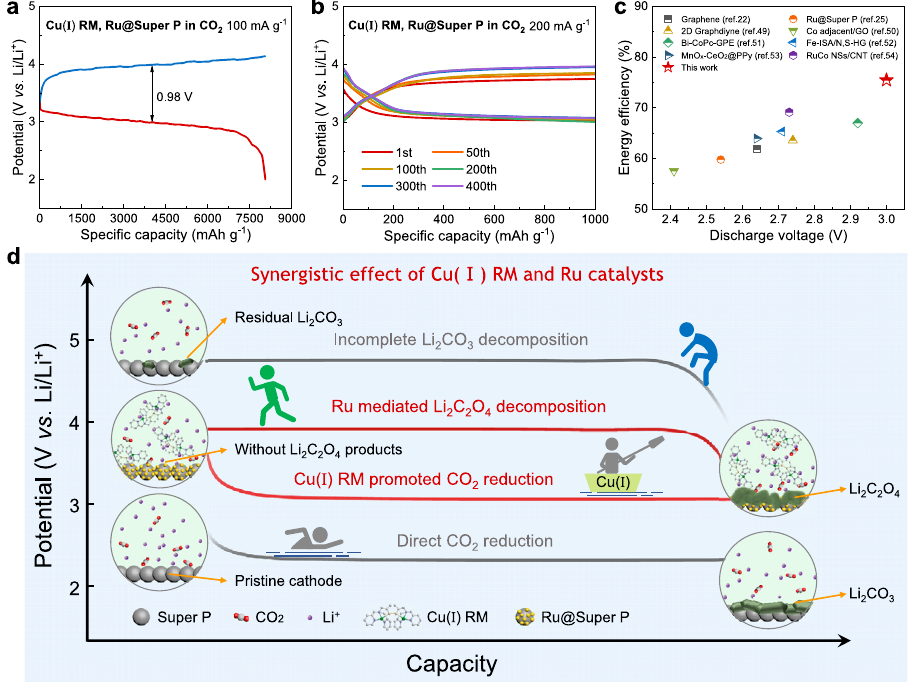
Fig. 4 | Optimization of charge performance by Ru catalysts. a Galvanostatic discharge-charge curves of the Li – CO 2 battery with a Cu(I) RM-based electrolyte and a Ru@Super P cathode during deep discharging at a current density of 100mAg − 1 . b Cyclic performance of the Li – CO 2 battery with a Cu(I) RM-based electrolyte and a Ru@Super P cathode under a fi xed speci fi c capacity